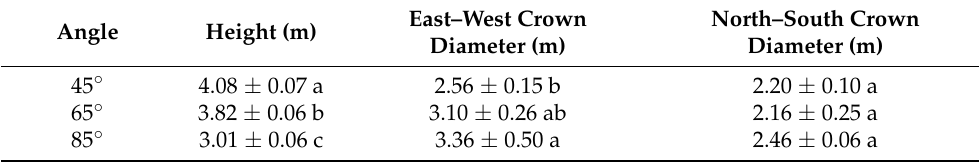
Table 1. Differences in peach tree canopy size with different main branch opening angles.